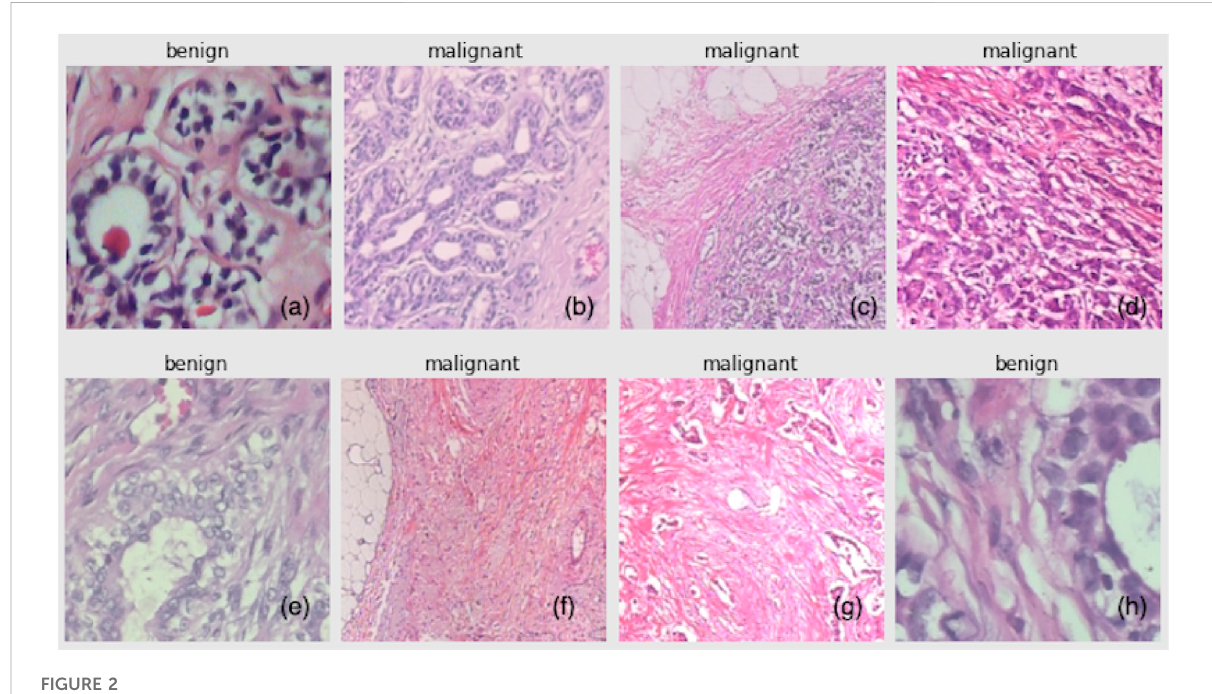
FIGURE 2 BreakHis samples: (A,E,H) are benign, and (B – D,F,G) are